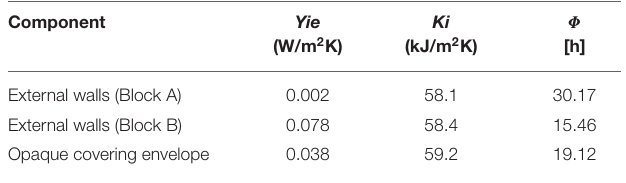
TABLE 3 | Dynamic thermal parameters.